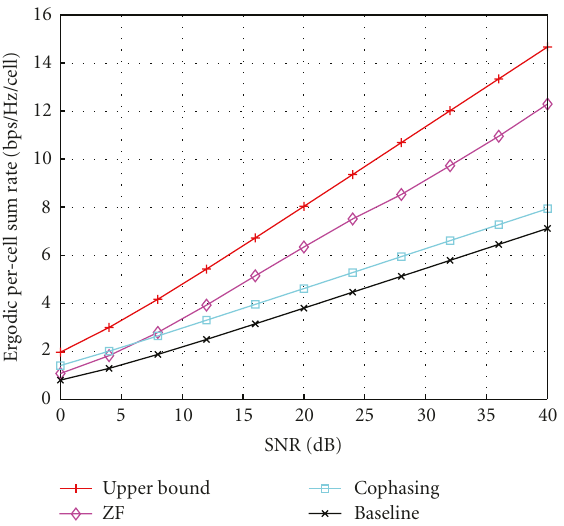
Figure 8: (64,4) single-class network with Rayleigh fading, Monte- Carlo simulation with 20 repetitions.